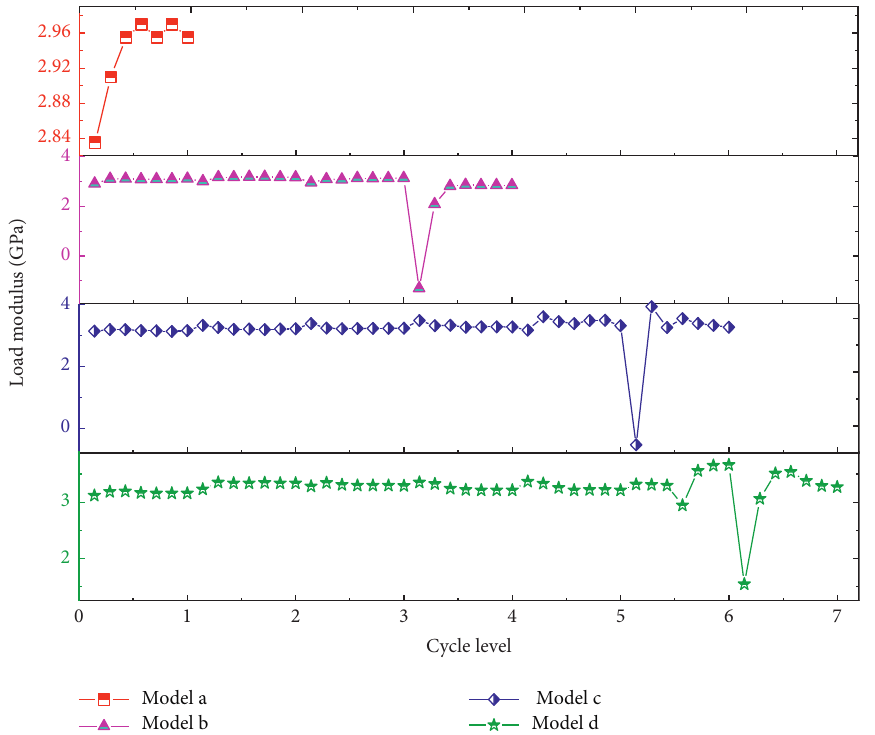
Figure 18: Load response (E + ) of coal sample with different particle numbers.